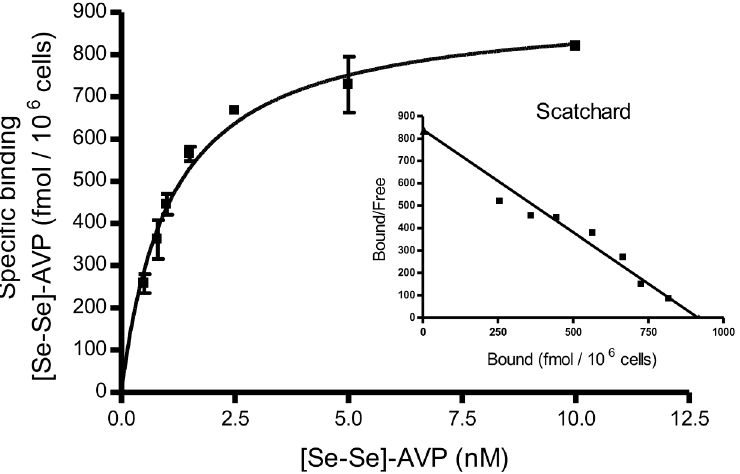
Fig 7. Specific binding of [Se-Se]-AVP peptide on V1A receptor expressed on CHO cells. Inset, Scatchard linear transformation of the data. Values represented on the graph are from a representative experiment performed in triplicate with corresponding